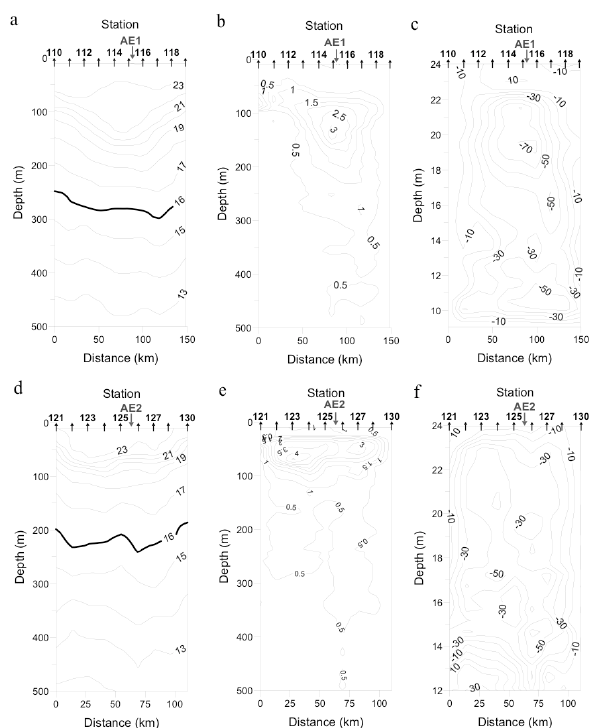
Fig. 3. Vertical sections from XBT transects showing the signals of anticyclonic eddies AE1 and AE2. Left panels, temperature ( ◦ C) section for (a) AE1 and (c) for AE2. Right panels, temperature anomaly ( ◦ C) sections for (b) AE1 and (d) AE2. Grey arrow in the top axes indicates the location of the eddy center signal. internal Graphik ist zu klein zu lesen, bitte groesser